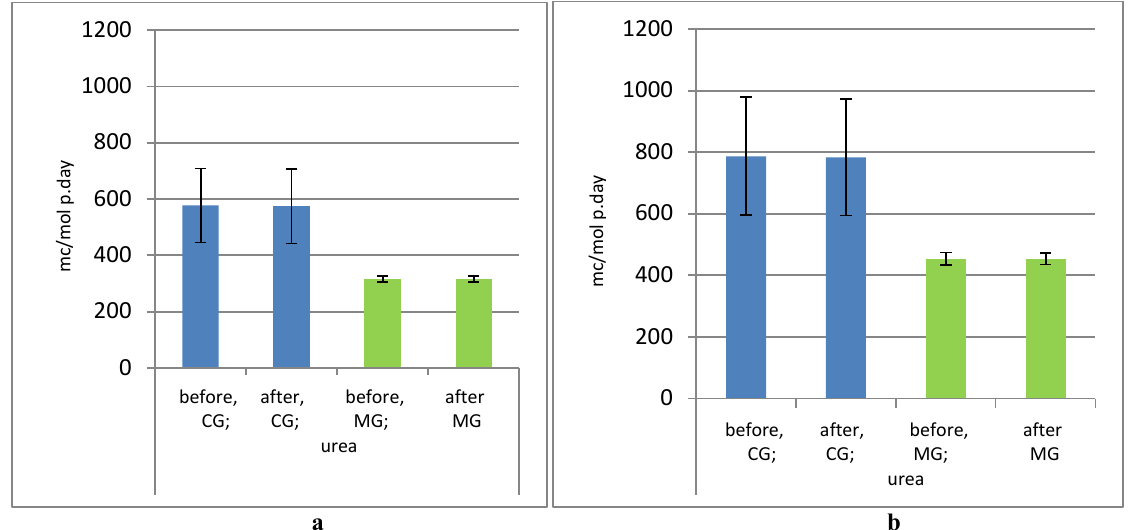
Fig.9. Indicators of bio-chemical monitoring by excretion of urea before and after experiment in mixed cluster (of main and comparative groups): a) by bicycle stress test «Vita maxima»; b) by results of control special tests. (р ≥ 0.05). CG – comparative group, MG – main